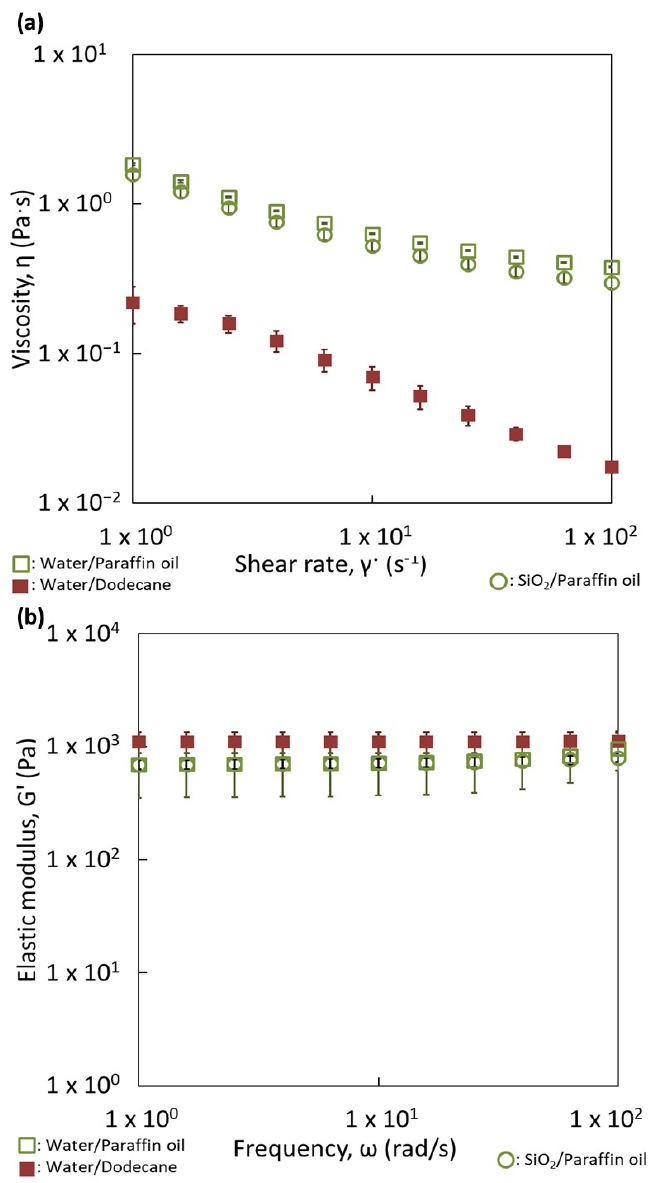
Figure 10. Comparison of the rheological behavior of Water/Paraffin and Water/Dodecane reverse emulsions prepared with ( a ) 1 wt.% and ( b ) 4 wt.% of partially hydrophobic silica particles. ( a ) Flow curves. ( b ) Mechanical spectra.